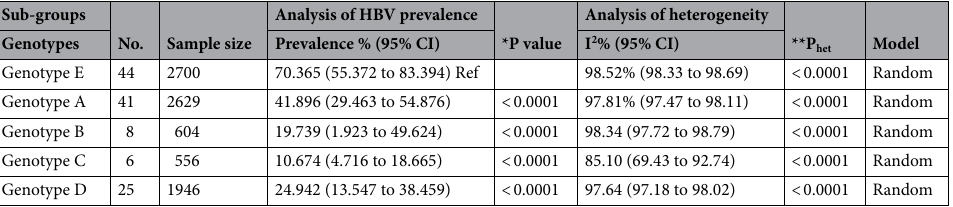
Table 1. Meta-analysis of the prevalence of the hepatitis B virus genotypes in Africa. *P value of genotype prevalence with respect to the reference genotype < 0.05 statistically significant. **P het < 0.1, the random-effects model was used for heterogeneity